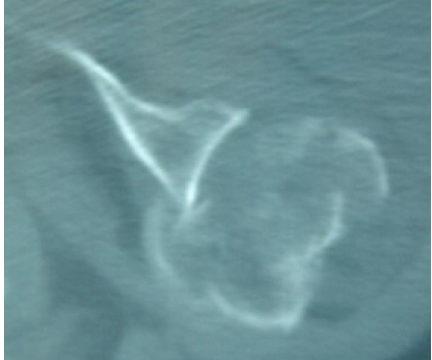
Figure 2. Initial CT